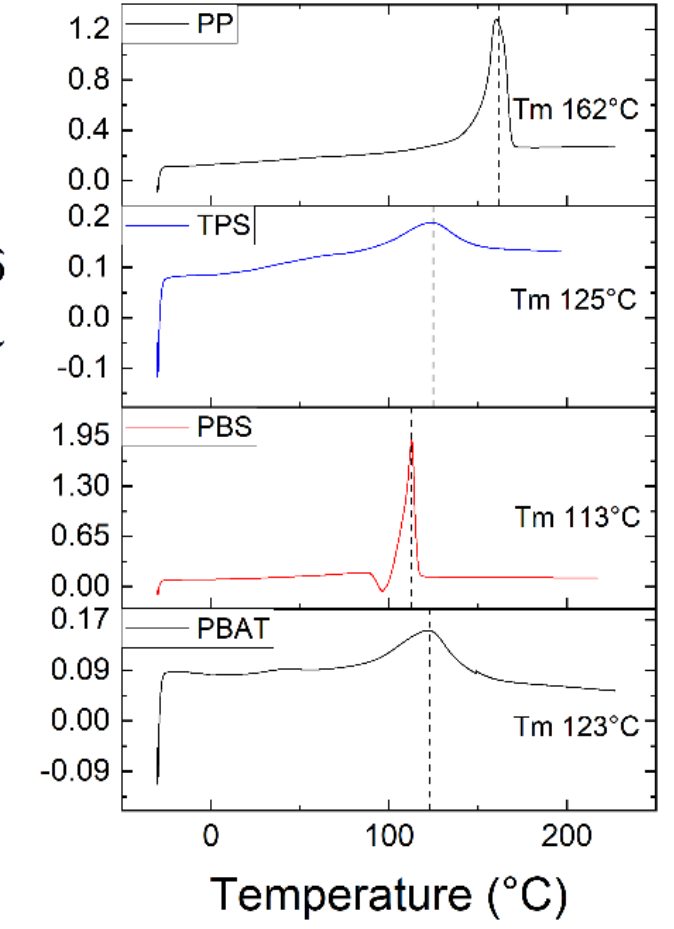
Figure 12. DSC analysis to determine the melting temperature (T m ) of the four polymers.